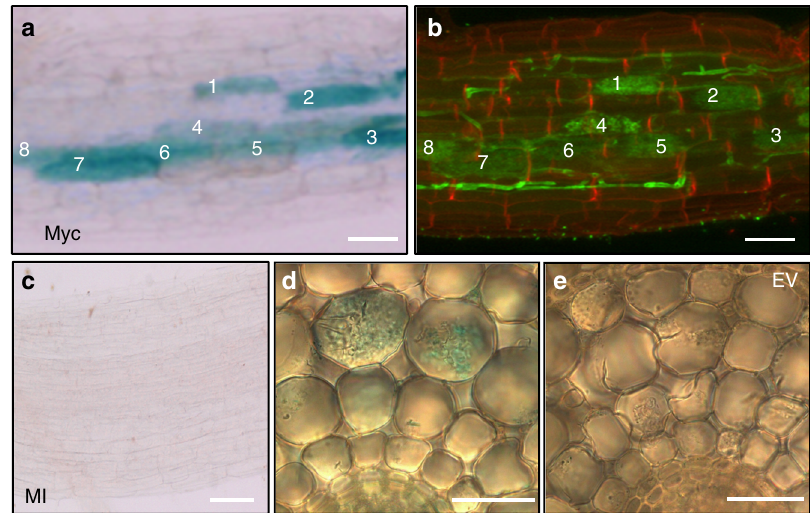
Fig. 2 Promoter activity of ARK1 in R. irregularis colonized roots. a GUS staining in cortical cells of R. irregularis colonized (Myc) pARK1:GUS roots containing arbuscules (numbered 1 – 8) but not in nonarbusculated cells at 6 weeks post-inoculation. b Wheat germ agglutinin (WGA)-Alexa Fluor 488-stained root sector from ( a ) showing intercellular hyphae and arbuscules (numbered 1 – 8). c Mock-inoculated (MI) control pARK1:GUS root lacks GUS staining. d Cross- section of inoculated pArk1:GUS and empty vector (EV) control ( e ) roots shows GUS staining exclusively in arbuscule-containing cells. Scale bar 100 μ m ( a , b ), 50 μ m ( c ), 10 μ m ( d , e ). Representative images of three roots from fi ve replicate plants are